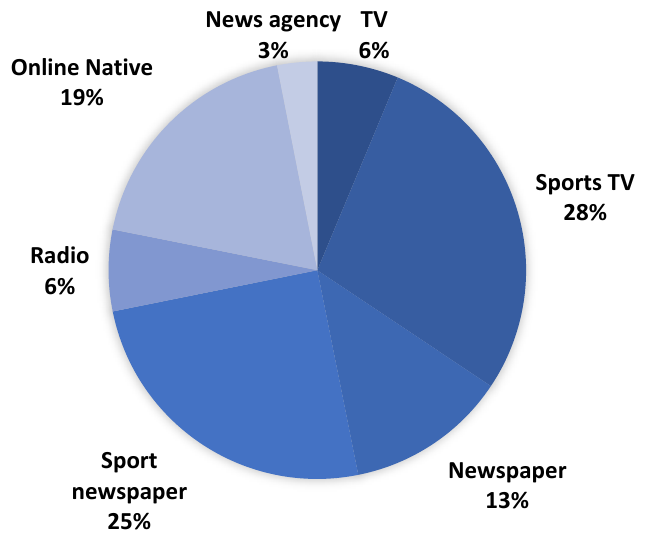
Figure 2. Media distribution.